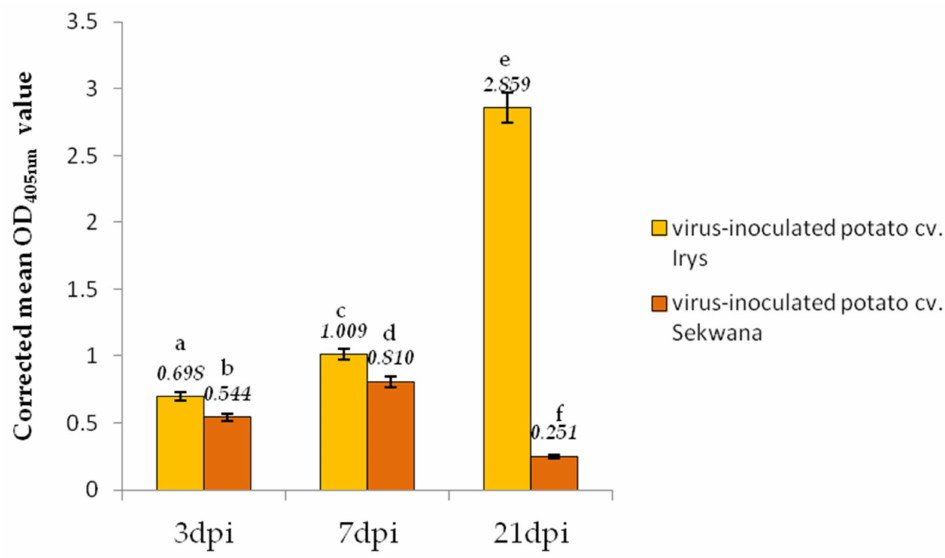
Figure 1. PVY NTN detection and relative virus concentration assessment in Irys and Sekwana plants at 3, 7, and 21 dpi. Values represent the mean OD 405nm values. The statistical significance of differences was assessed at p < 0.05 using ANOVA with post hoc Tukey’s HSD (marked by numbers above the